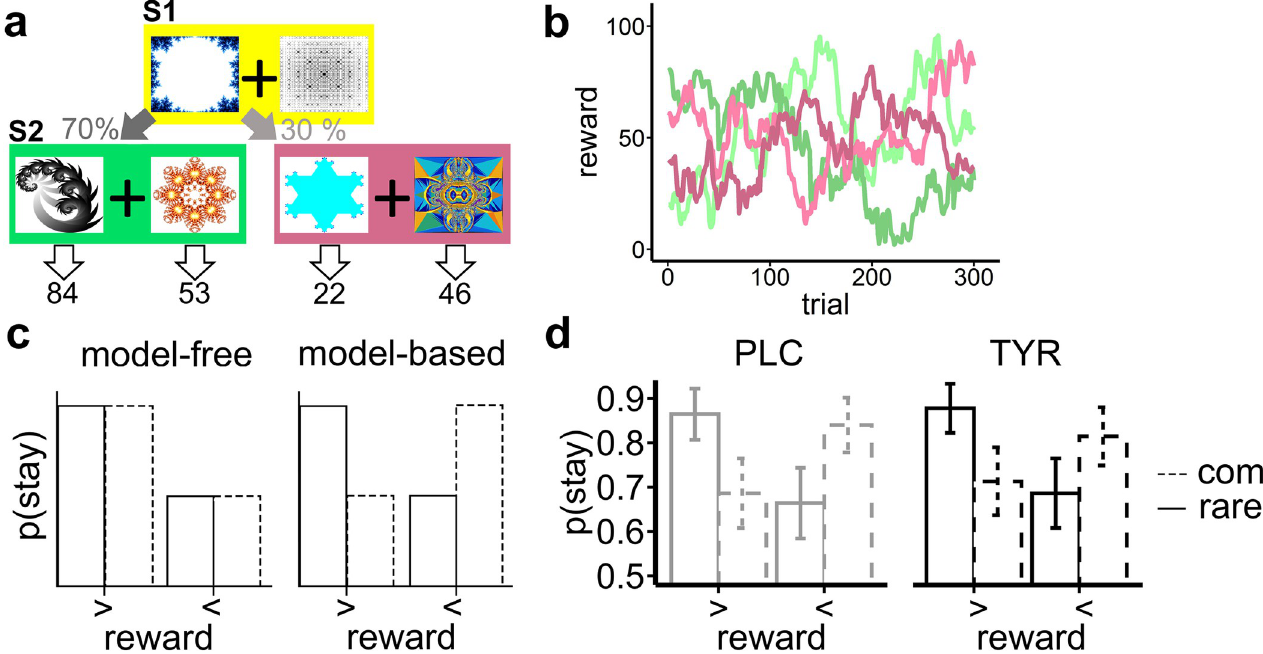
Fig 1. (A) Schematic illustration of the seq. reinforcement learning task structure. In each of 300 trials, participants started in stage S1 with a binary choice between two fractals (shown fractals are taken from https://openclipart.org/). Each of the two stimuli was associated with a common (70%) and a rare (30%) transition probability to the two possible states (color coded, here: green / violet) in decision stage S2. In decision stage S2 each stimuli was associated with fluctuating reward points that followed (B) Gaussian random walks with reflecting boundaries at 0 and 100, and standard deviation of 2.5. (C) Putative stay probabilities in decision stage S1 of a pure model-free or pure model-based learner as a function of previous reward height ( > / < compared with the preceding 20 trials) and experienced transition probability in the previous trial (common / rare). (D) Participants stay probabilities in stage S1 following placebo (PLC) and tyrosine